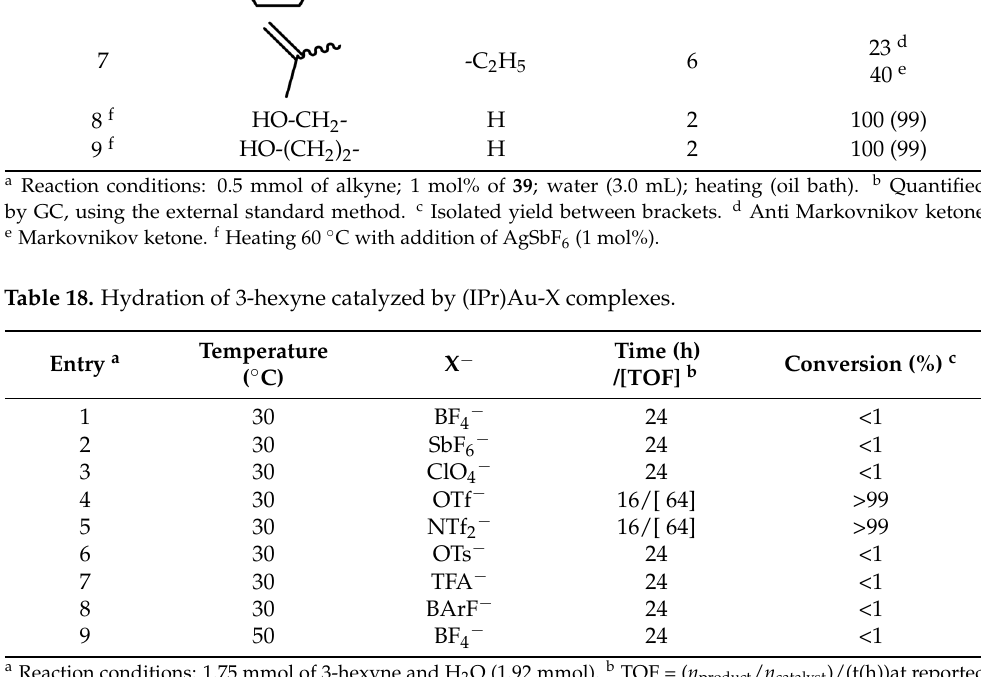
Table 18 . Hydration of 3-hexyne catalyzed by (IPr)Au-X complexes. Entry a